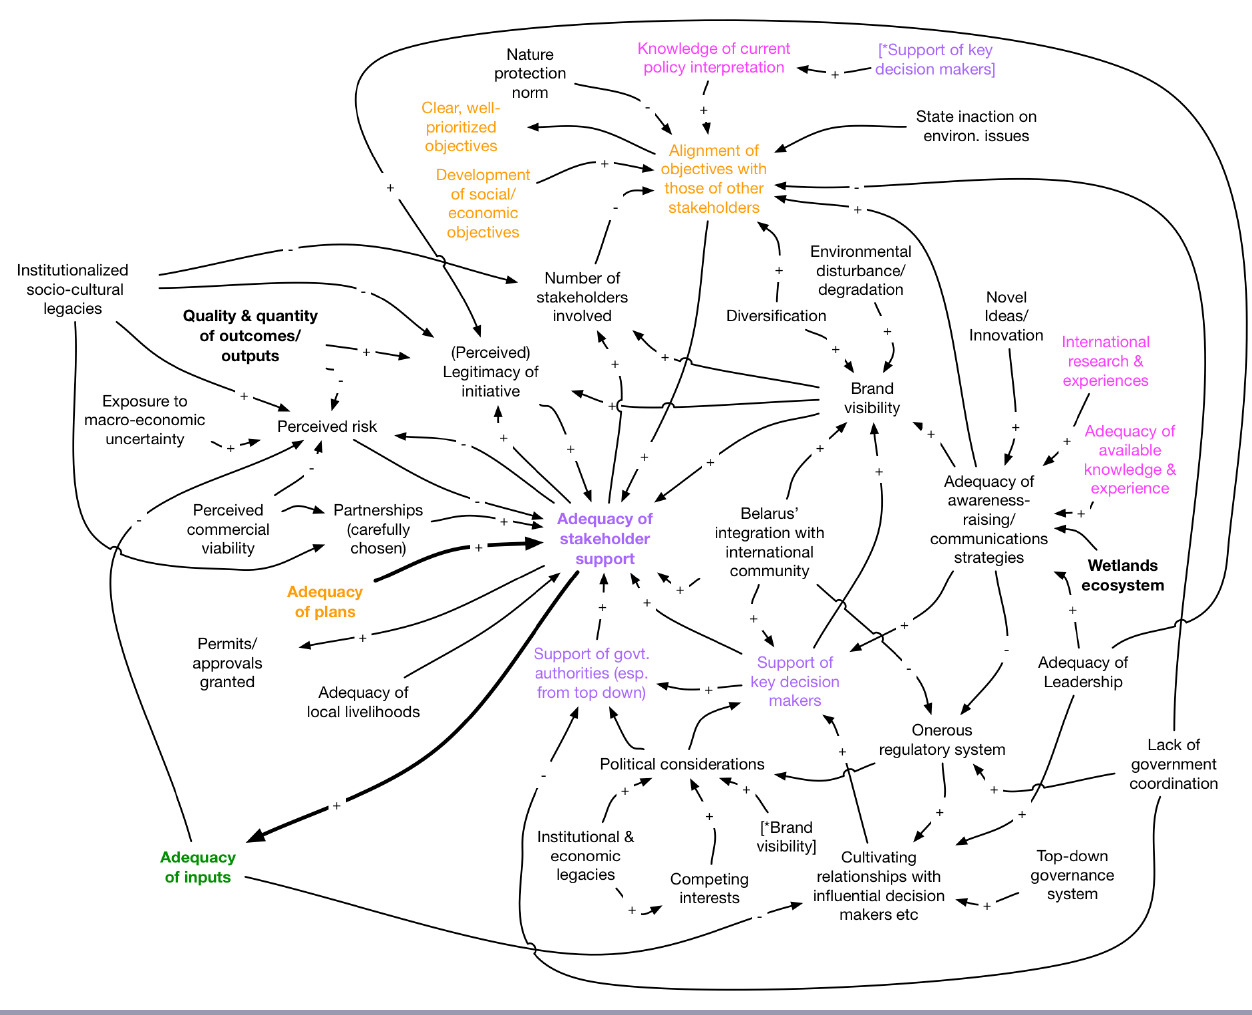
Fig. 6 . Submodel unpacking causal dynamics influencing adequacy of stakeholder support, which is partially disaggregated in this diagram to clarify key dynamics relating to the support of two important stakeholder types, government authorities and key decision makers. Although other drivers of support, e.g., brand visibility, or legitimacy of initiative, also influence these subconcepts, these relationships are not explicitly represented here, for the sake of diagrammatic clarity and to avoid double-